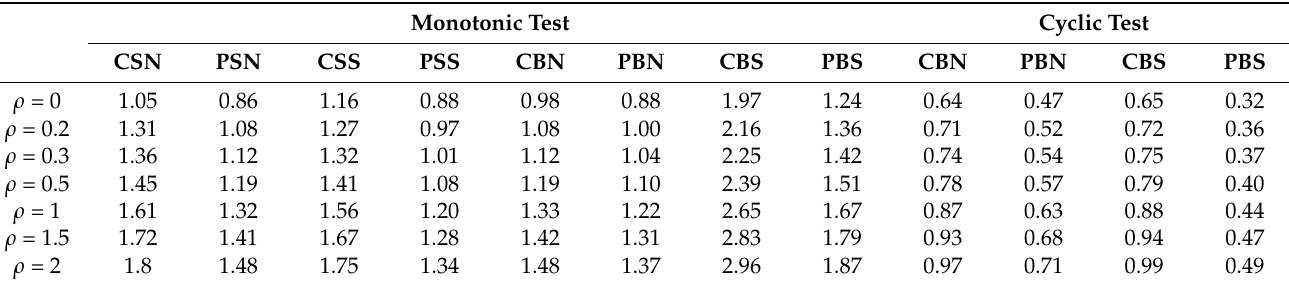
Table 7. Modification factor values of joints.